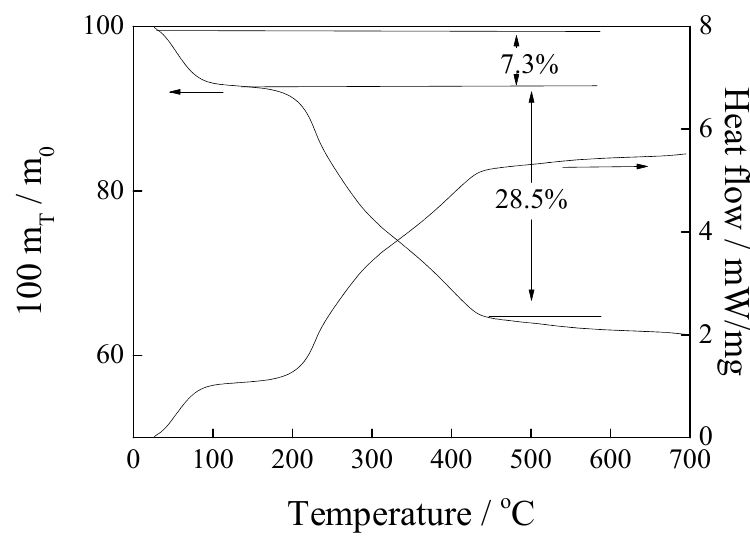
Figure 10. The TG-DSC curve of the magnesite modified by [APMIM]Br. Figure 11 shows the infrared spectra of the magnesite modified by [APMIM]Br with different loading amounts and the 30% loading amount of the modified magnesite after adsorption. The strength of both the imidazole ring characteristic and C–N group peaks at 1168 and 1334 cm −1 , respectively, is in the order of the loading amounts of 30% > 20% > 10%. Moreover, the strength magnitudes of the peaks after CO 2 adsorption decrease. The CO 2 adsorption capacity determined experimentally of the different ILs and loading amounts are consistent with the strengthening of the imidazole ring and C–N groups (Figures 2 and 11), indicating that improving the conjugative effect of the imidazole ring can enhance the adsorption performance.